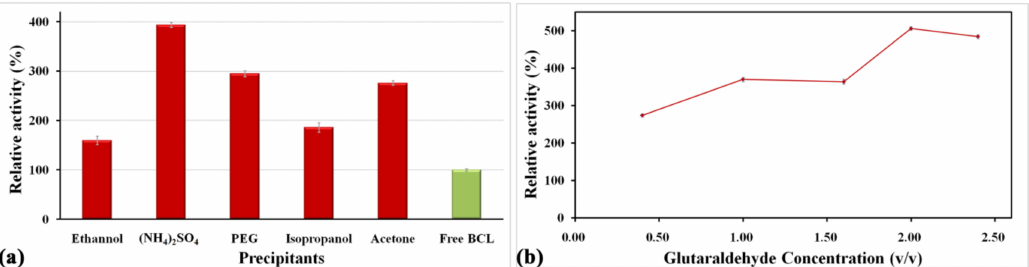
Figure 4. ( a ) Precipitant type and ( b ) glutaraldehyde concentration on the activities of BCL